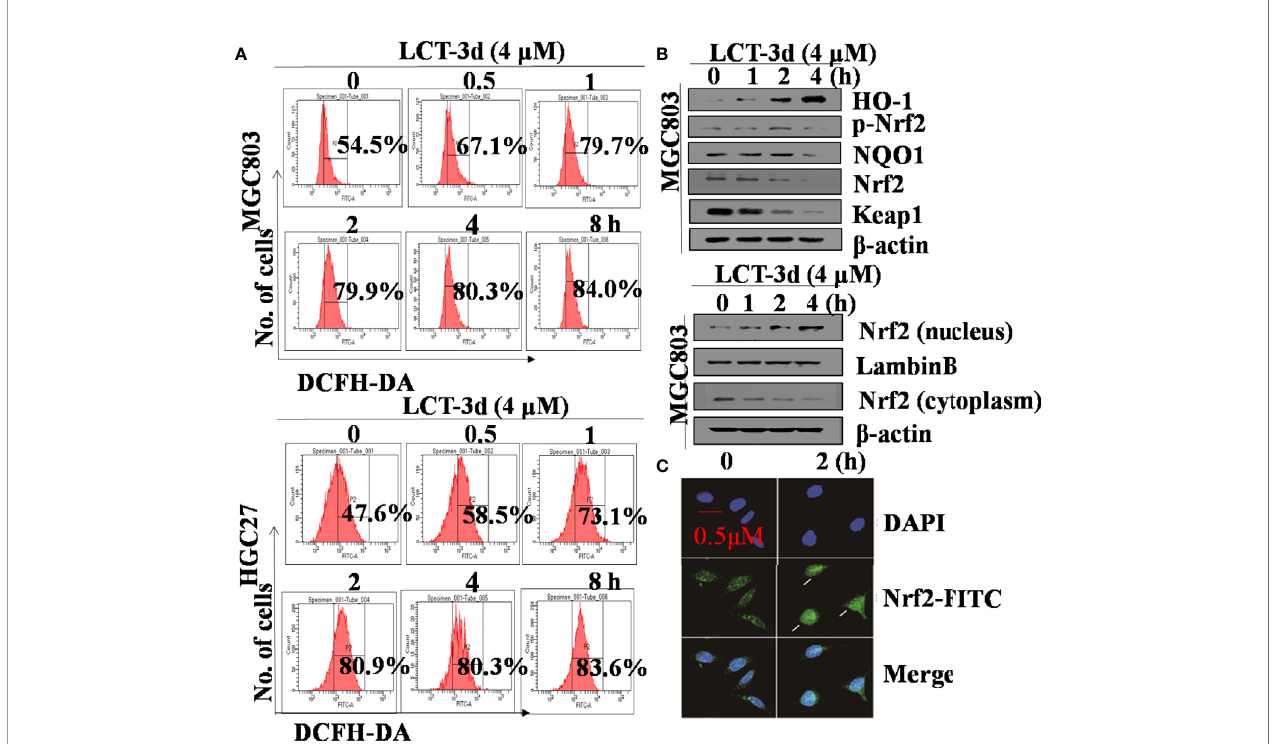
FIGURE 5 | LCT-3d increased the level of ROS in gastric cancer cells. (A) MGC803 cells and HGC27 cells were treated with LCT-3d (4 m M) for indicated times and the level of ROS was detected by DCFH-DA with fl ow cytometry. (B) Western blotting assay showed Nrf2 nuclear-translocation and the changes of LCT-3d-induced protein expression at indicated time points. (C) MGC803 cells were treated with LCT-3d (4 m M) for 2 h. The treated and untreated samples are stained with Nrf2 antibody (Green) and DAPI (Blue) (magni fi cation, 400×). The arrows indicate Nrf2 nuclear